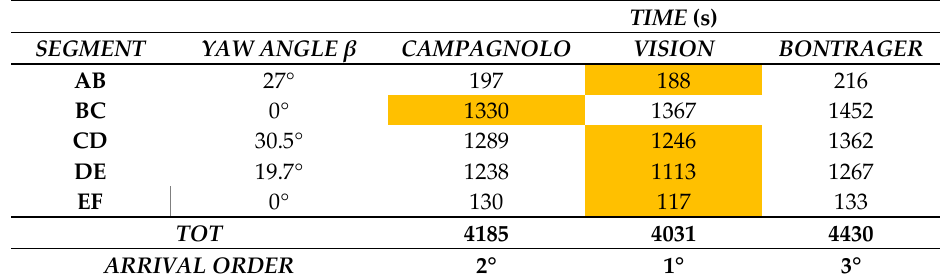
Figure 5. ( a,c ) Drag and ( b,d ) side effective frontal areas of the three wheelsets varying the yaw angle ß (by 5° increments) with a constant wind speed referred to the bicycle V WB of 40 km/h and 50 km/h; ( e ) drag and ( f ) side effective frontal areas of the three wheelsets varying the yaw angle ß (5° increments) with a constant wind speed referred to the ground V WG of 20 km/h. Table 1. Time results of the race simulation. The yellow background indicates the fastest wheels in each